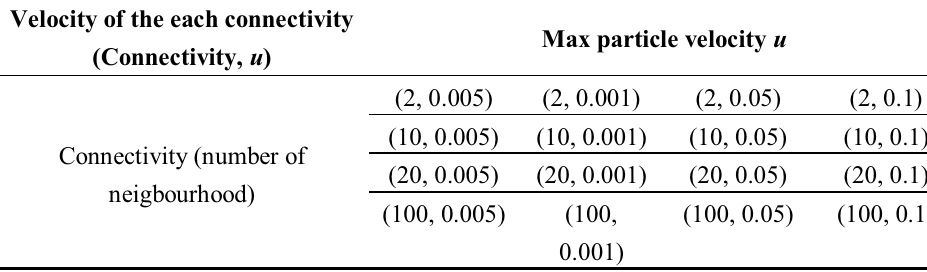
Table 6. The test parameters for the PSO [38]. Velocity of the each